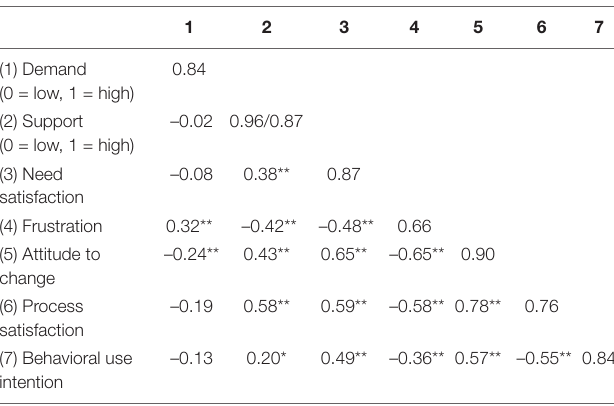
TABLE 2 | Correlation matrix of Study